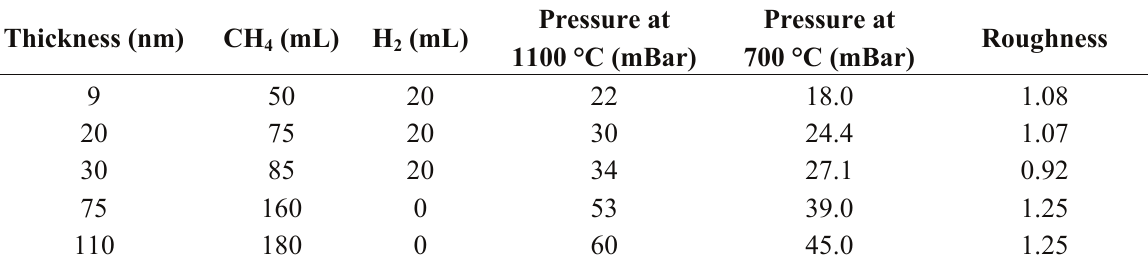
Table 1. PyC films synthesis